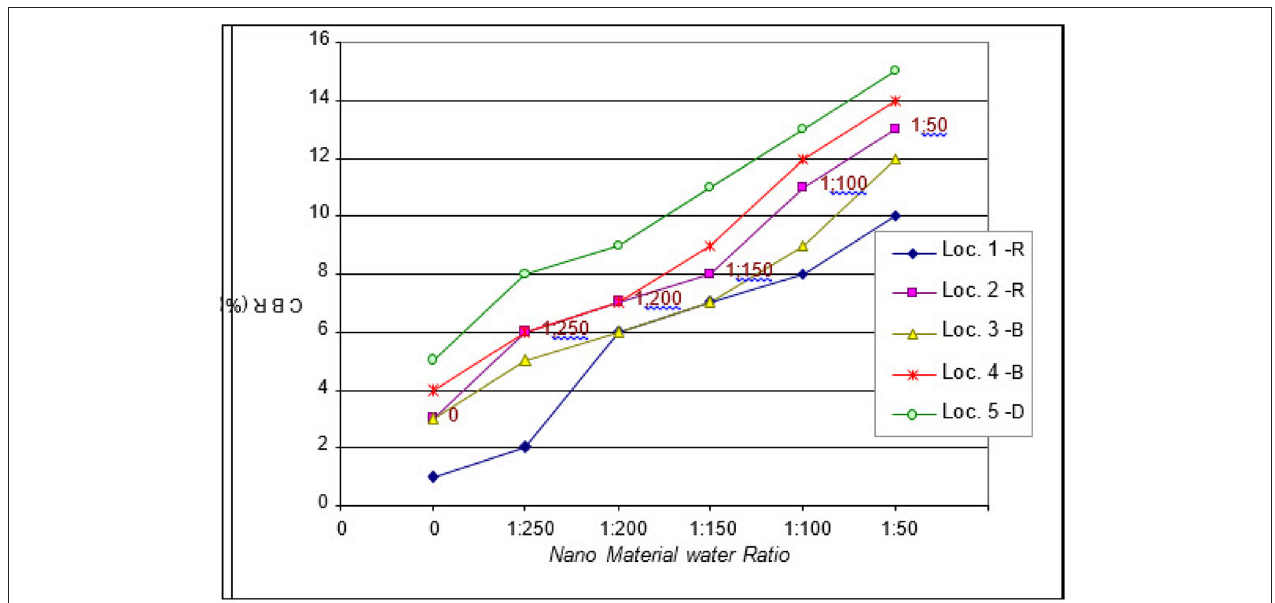
FIGURE 10 | Variation of California bearing ratio with nanomaterial content.